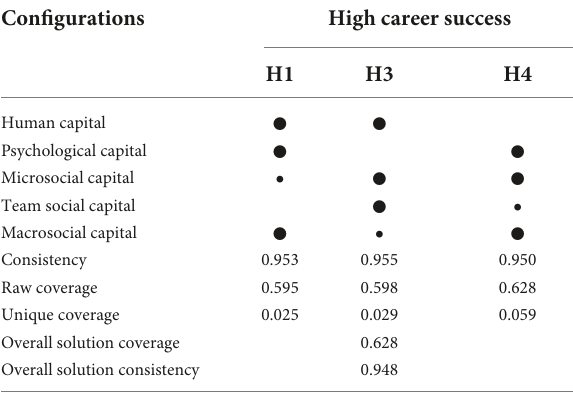
TABLE 8 The configuration after improving the PRI